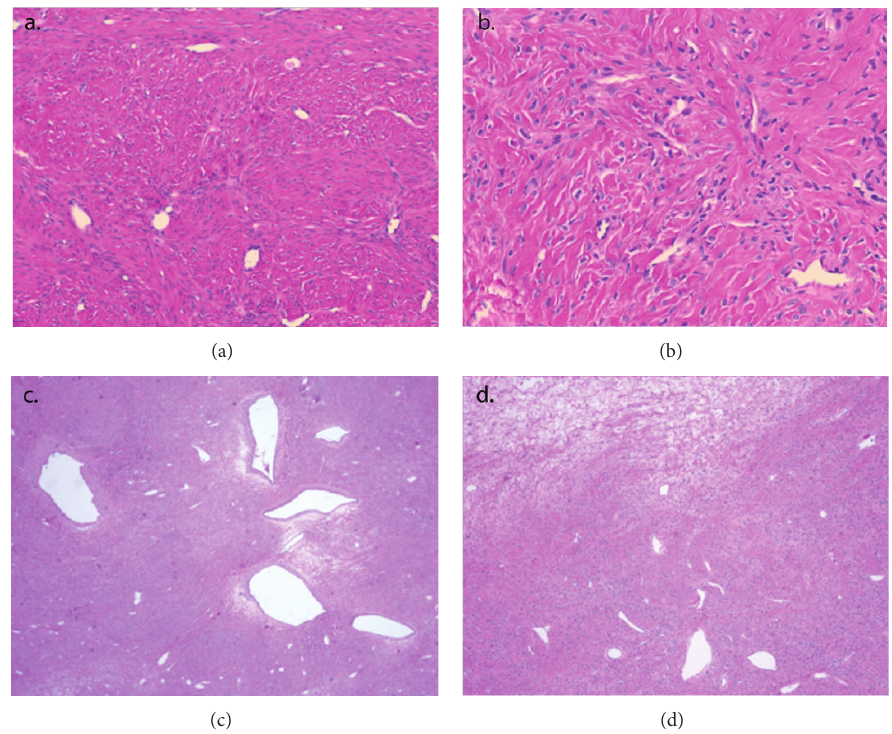
Figure 4: Hematoxylin and eosin stained slides. (a) Right ovarian mass with vague nodular outlines of pseudolobular architecture with variable hypercellular and hypocellular areas, 100x. (b) Right ovarian mass with marked vascularity composed of thin-walled and hemangiopericytoma-like vessels and interlobular fibrosis, 200x. (c) Left ovary with prominent ectatic vessels, 20x. (d) Left ovary with focal stromal edema (top left) and multiple ectatic and hemangiopericytomatous vessels,